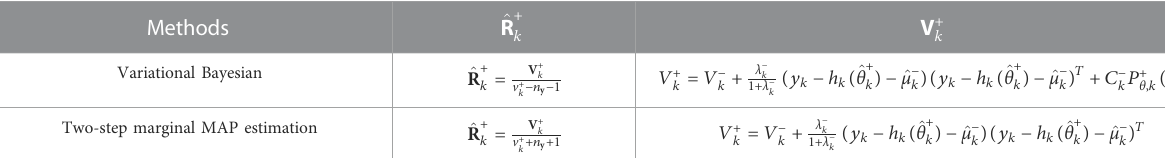
TABLE 1 Differences between the proposed VB method and two-step marginal MAP estimation